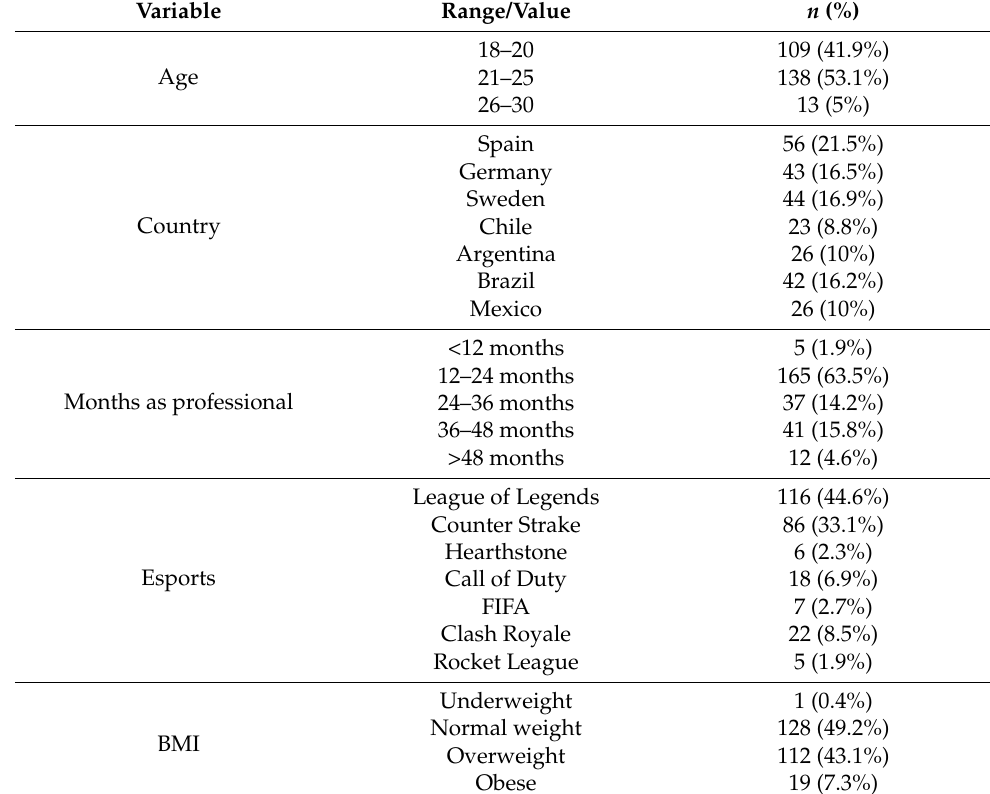
Table 1. Characteristics of the